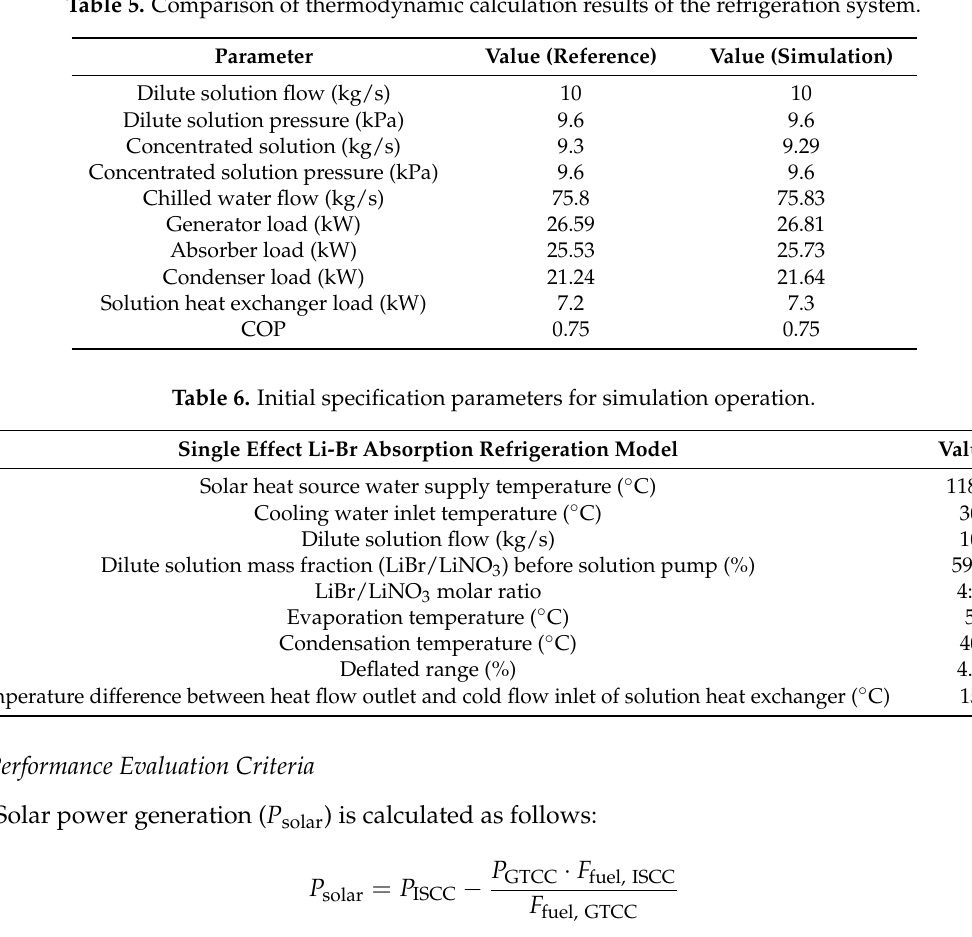
Table 5. Comparison of thermodynamic calculation results of the refrigeration system.